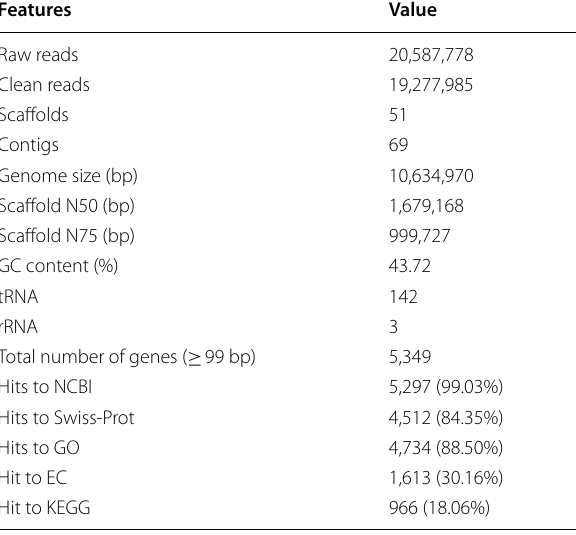
Table 1 Assembly statistics of M. guilliermondii strain SO genome features demonstrated from de novo Velvet program